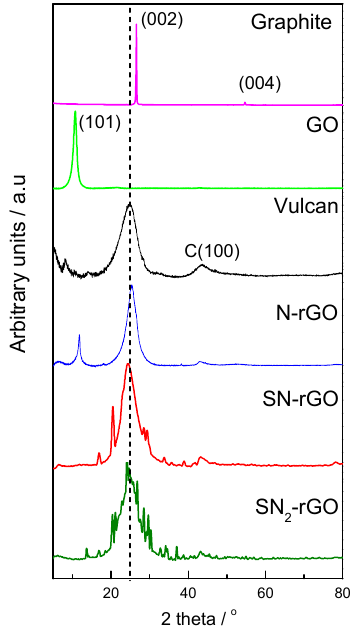
Figure 1. X ‐ ray diffraction (XRD) patterns for all studied materials. Figure 1. X-ray diffraction (XRD) patterns for all studied